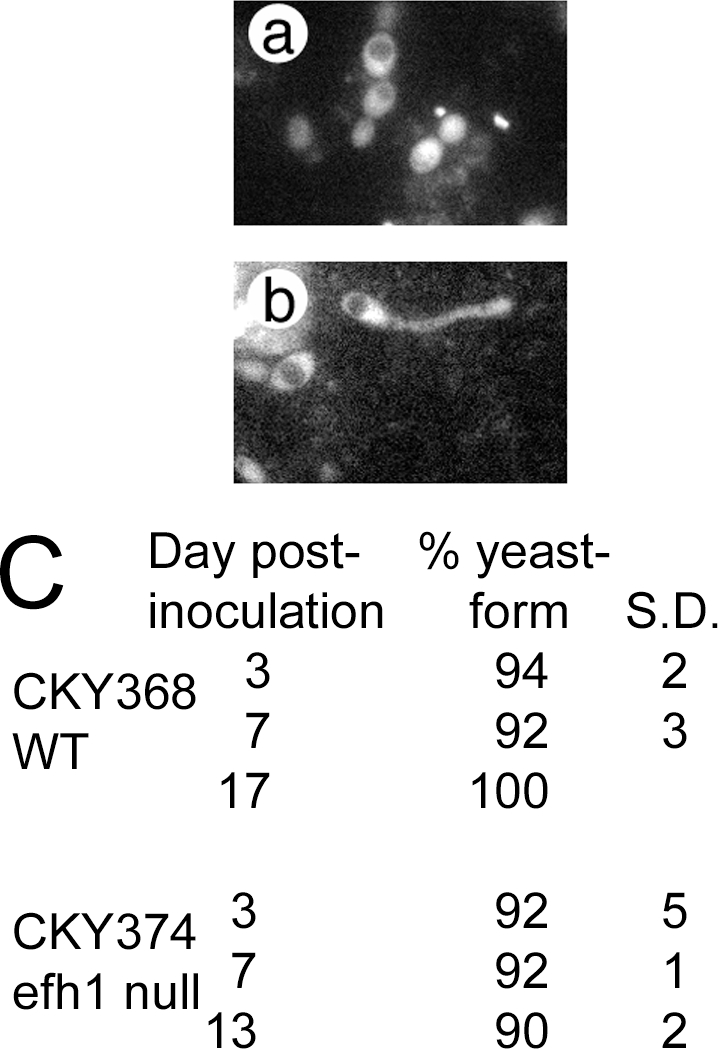

C. albicans Cells Colonizing the Murine Intestinal Tract Are Predominantly in the Yeast Form(A and B) Contents of the ileum of mice inoculated with C. albicans strain CKY368, WT, GFP-expressing, day 3 post-inoculation (A) or strain CKY374, efh1 null mutant, GFP-expressing day 13, post-inoculation (B). Fluorescence micrographs show the morphology of yeast-form cells (A) or hyphal-form cells (B).(C) Quantitation of cellular morphology.